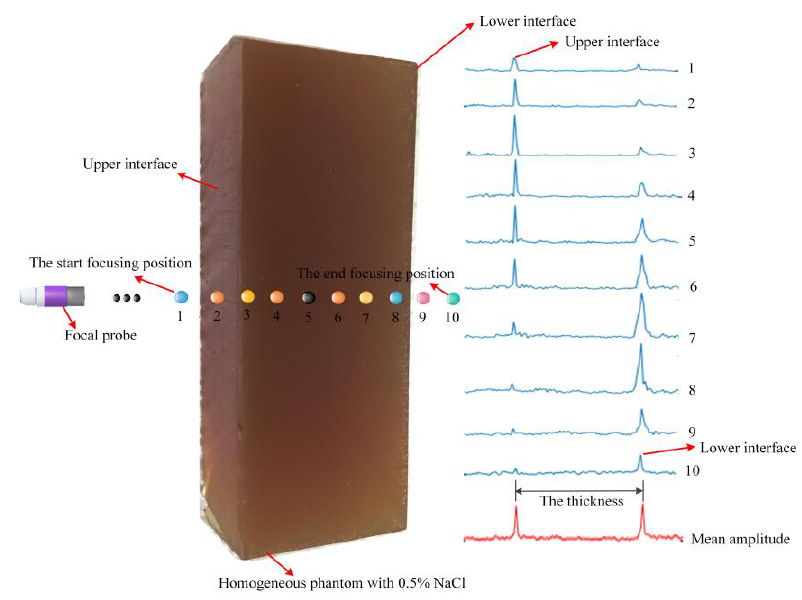
Figure 5. The movement track of the focal point position and the amplitude variation of conductivity curves of 10 step-scan movements in the depth direction.